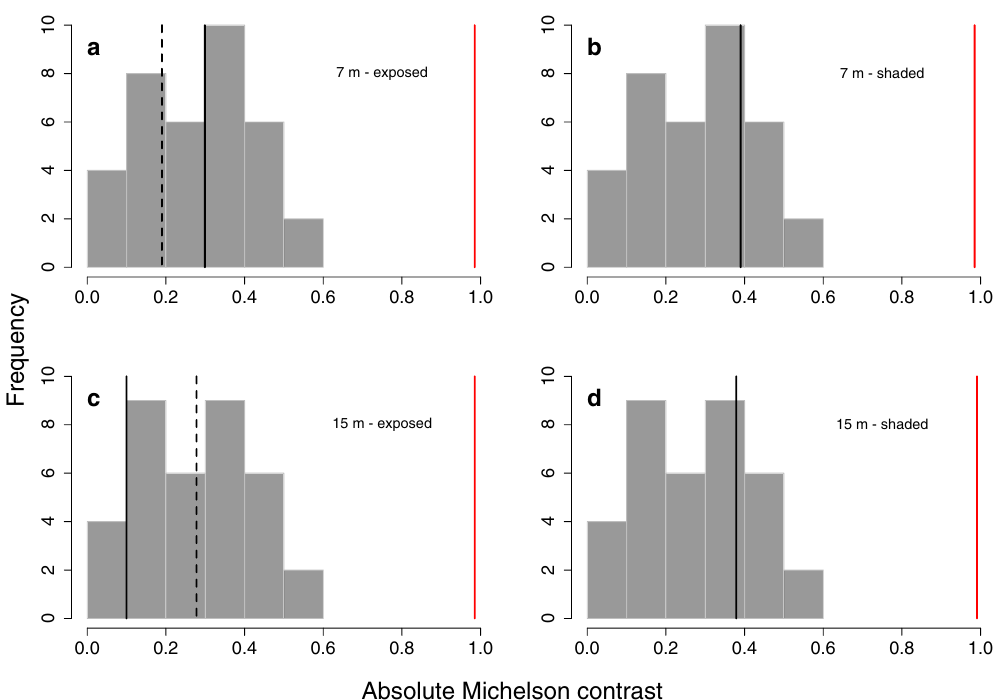
Figure 7. Predicted absolute achromatic contrast of the pupil with and without eyeshine against the iris of Scorpaena porcus compared to the contrast among body patches as perceived by a prey species. The achromatic contrast between a natural pupil with eyeshine and its iris (black lines) was small and fell within the distribution of the achromatic contrasts between skin patches (all combinations of four patches in each of the three fish measured; histogram bars). This was not the case when eyeshine was prevented, as in the dark model pupil (red lines). Black lines indicate contrast values between the natural pupil and the iris when Tripterygion delaisi is shaded (dashed) or exposed (solid) for four S. porcus scenarios: ( a ) exposed and ( b ) shaded at 7 m depth, ( c ) exposed and ( d ) shaded at 15 m depth. Red lines indicate contrast values between the dark model pupil and the iris when T. delaisi is shaded (dashed) or exposed (solid) for the same four S. porcus scenarios (note that in scenario (a) and (c) two lines